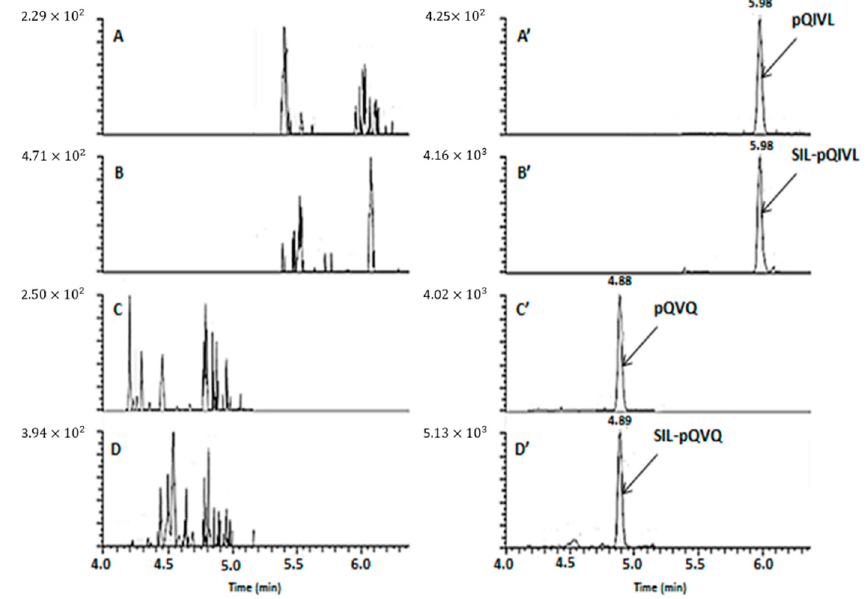
Figure 5. Multiple-reaction monitoring (MRM) chromatograms with LC-MS/MS assay of rituximab ( A ) , ( A’ ) and ( C ), ( C’ ) and SIL-rituximab ( B ), ( B’ ) and ( D ), ( D’ ). A, B, C, D: blank sample; A’ and C’: sample spiked at 5 µg/mL (LLOQ); B’ and D’: SIL-rituximab at 15 µg/mL. Table 3. Inter-day validation of the determination of rituximab in plasma by LC-MS/HRMS using either FSGS or pQVQ proteotypic peptides. Data from seven calibration curves were prepared as a single replicate and analyzed on seven different days.